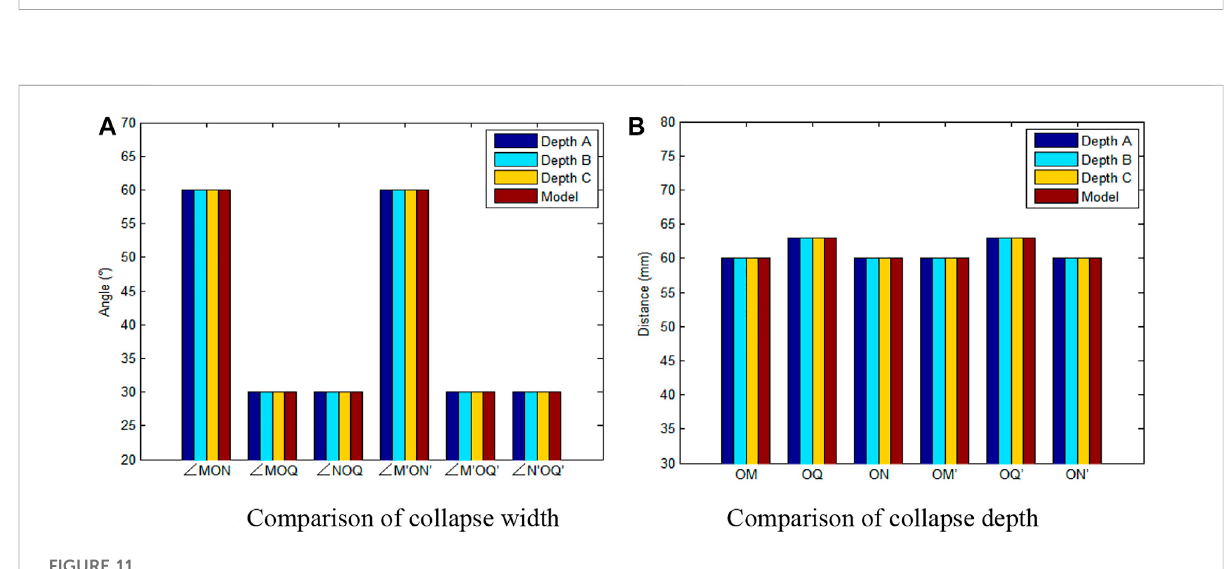
FIGURE 11 Comparison of